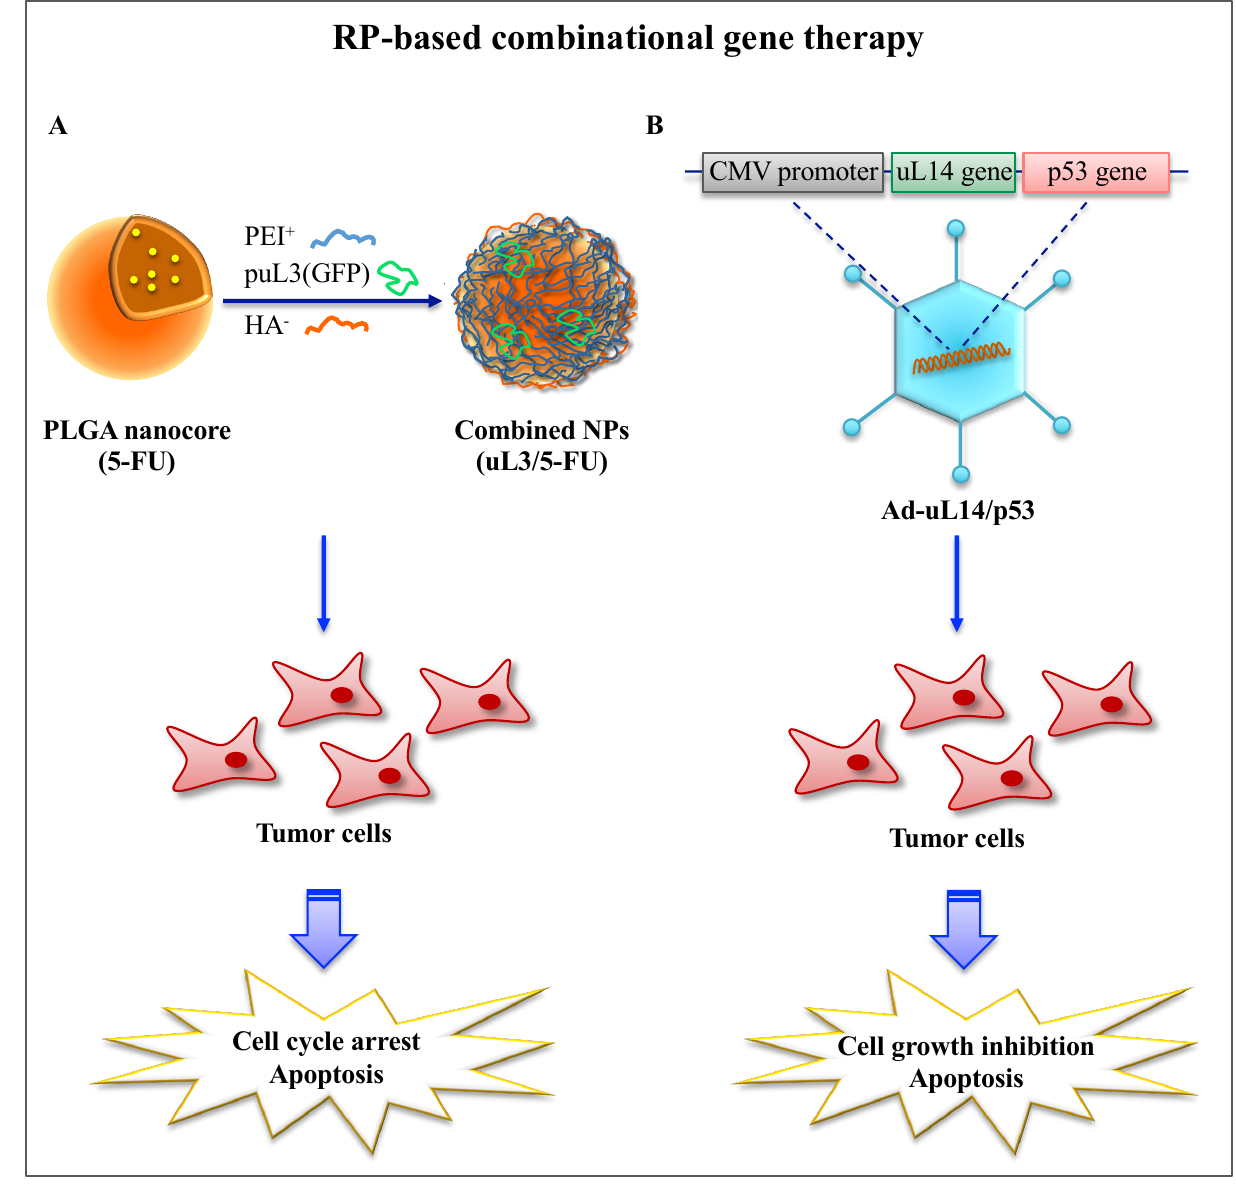
Figure 3. Strategies of RP-based gene therapy. ( A ) Polymeric nanoparticles with a core of PLGA and a polymer shell of HA and PEI as platform to deliver the 5-FU and the pro-apoptotic protein uL3. ( B ) Bicistronic adenovirus expressing both the uL14 and p53 genes